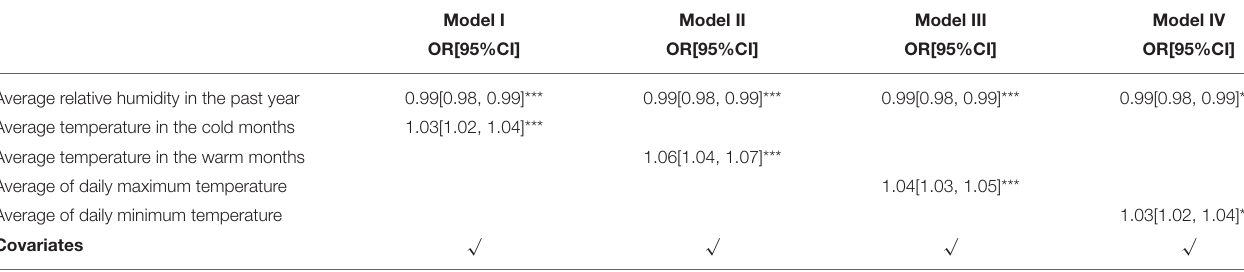
TABLE 3 | Effects of air relative humidity and temperature on Cataracts: Odds Ratios (OR) from hierarchical GEE